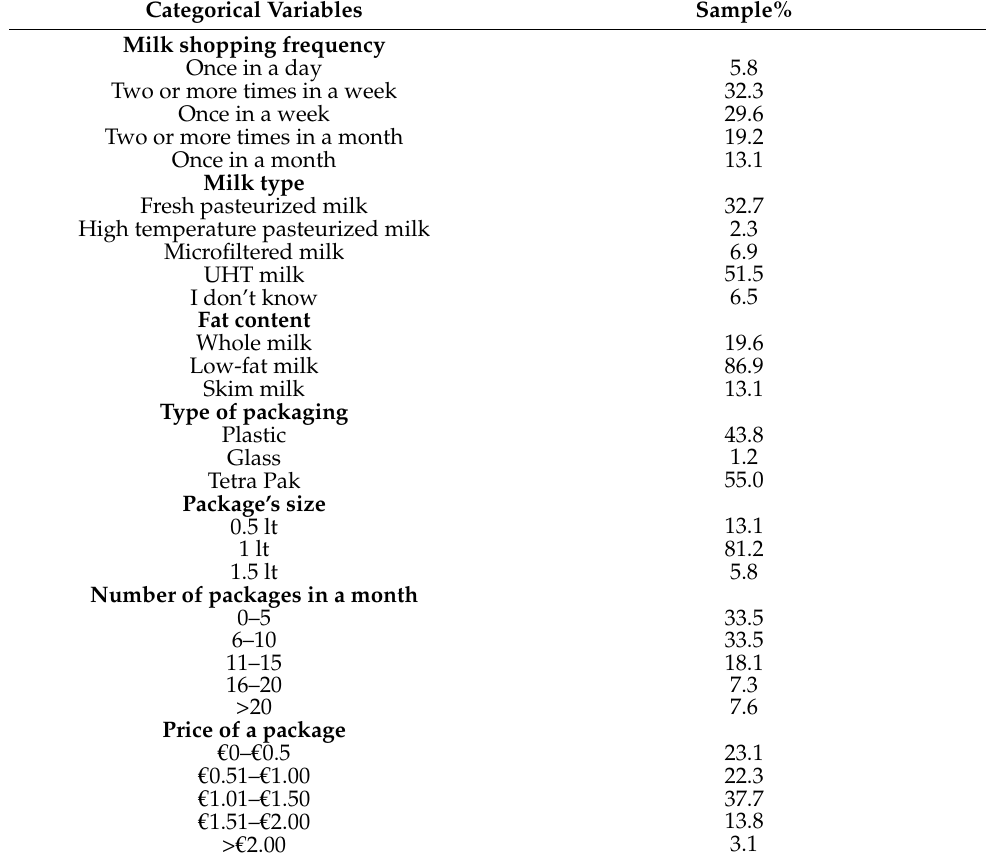
Table 1. Milk shopping habits ( n = 260). Categorical